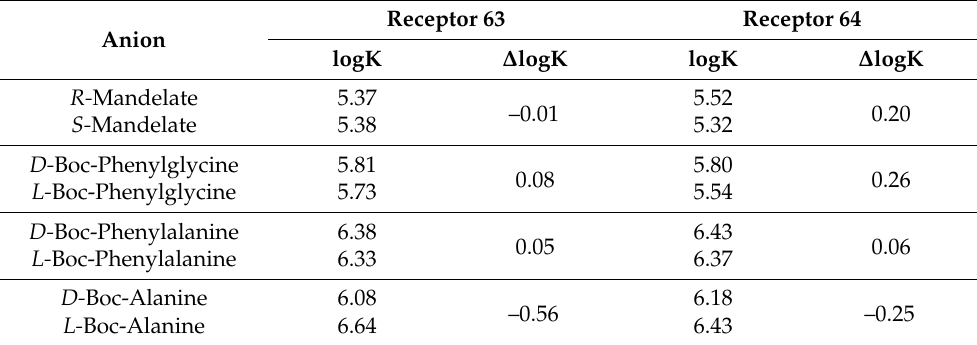
Table 4. Association constants of complexes for receptors 63 and 64 in acetonitrile with 1% DMSO.